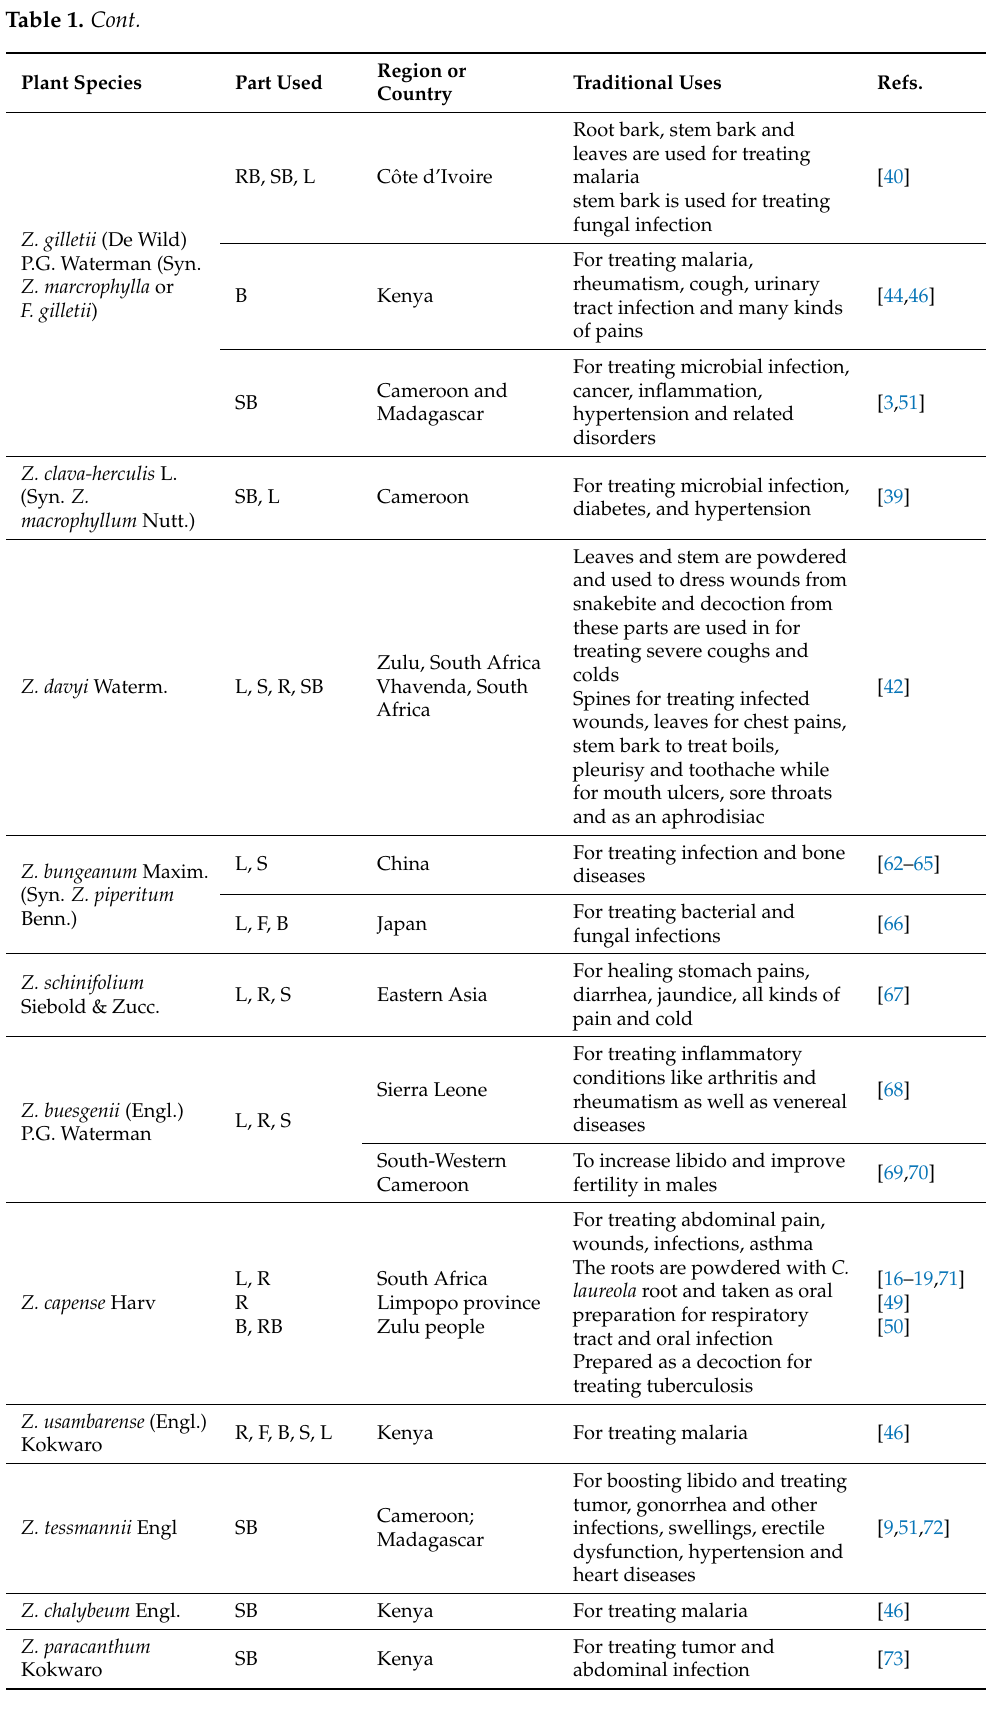
Table 1. Cont. Plant Species Part Used